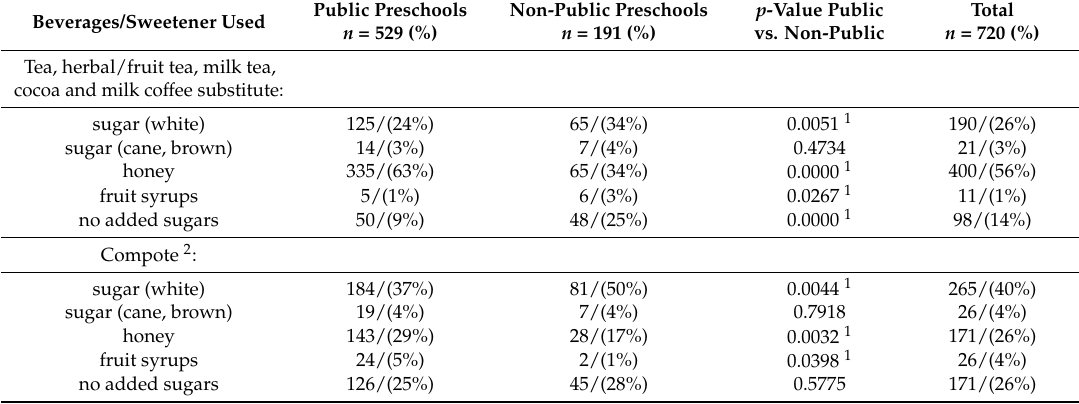
preschools: comparison of public and non-public institution, and data for the total